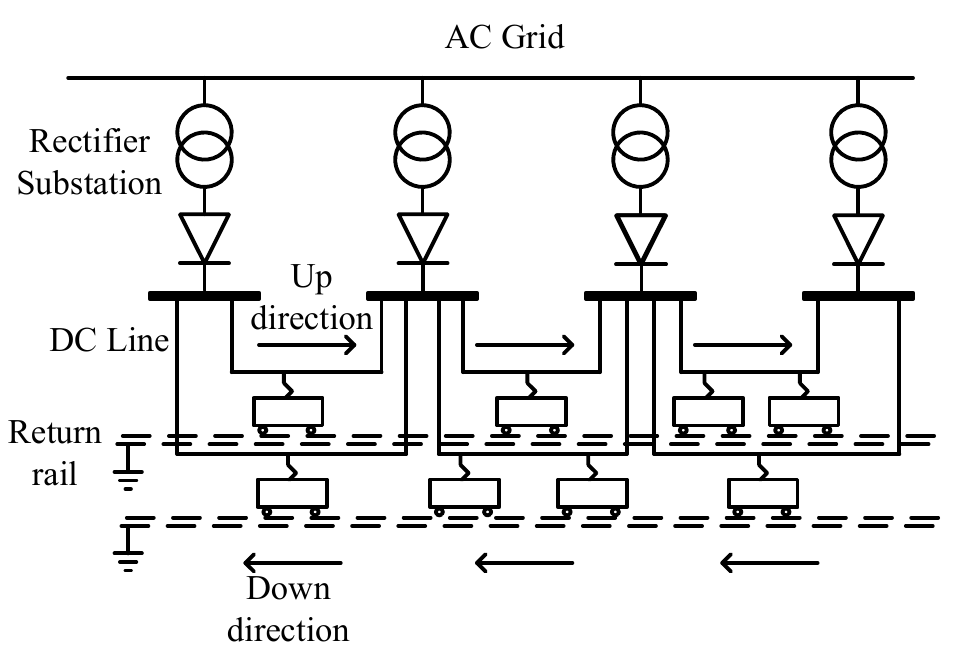
Figure 1. The typical DC traction power network with multi-trains.